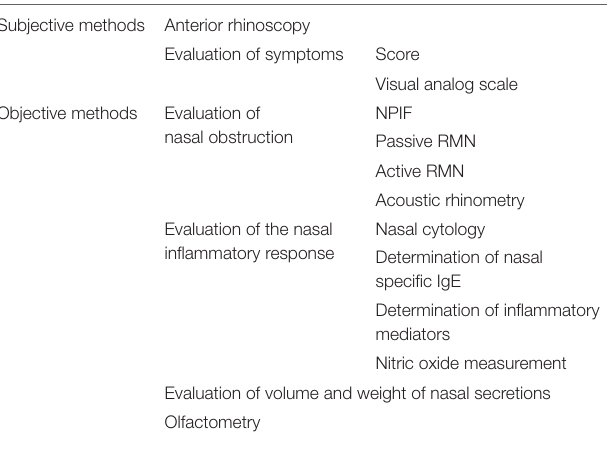
TABLE 1 | Methods of measuring the nasal response to allergens